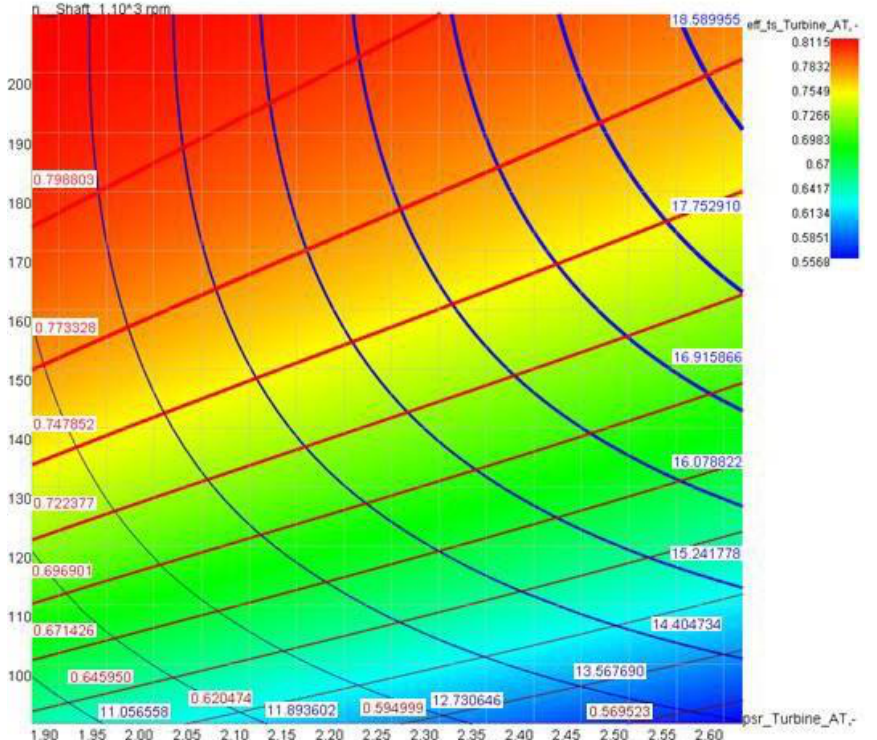
Figure 17. 3D Range 1 turbine map ( y -axis: shaft speed in rpm (1000 s); x -axis: turbine pressure ratio). The legend at the top right-hand side indicates the range of total-to-static turbine efficiency.